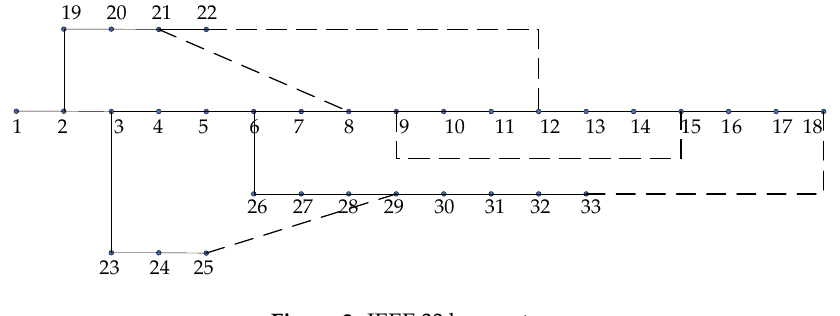
Figure 2. IEEE 33 bus system.